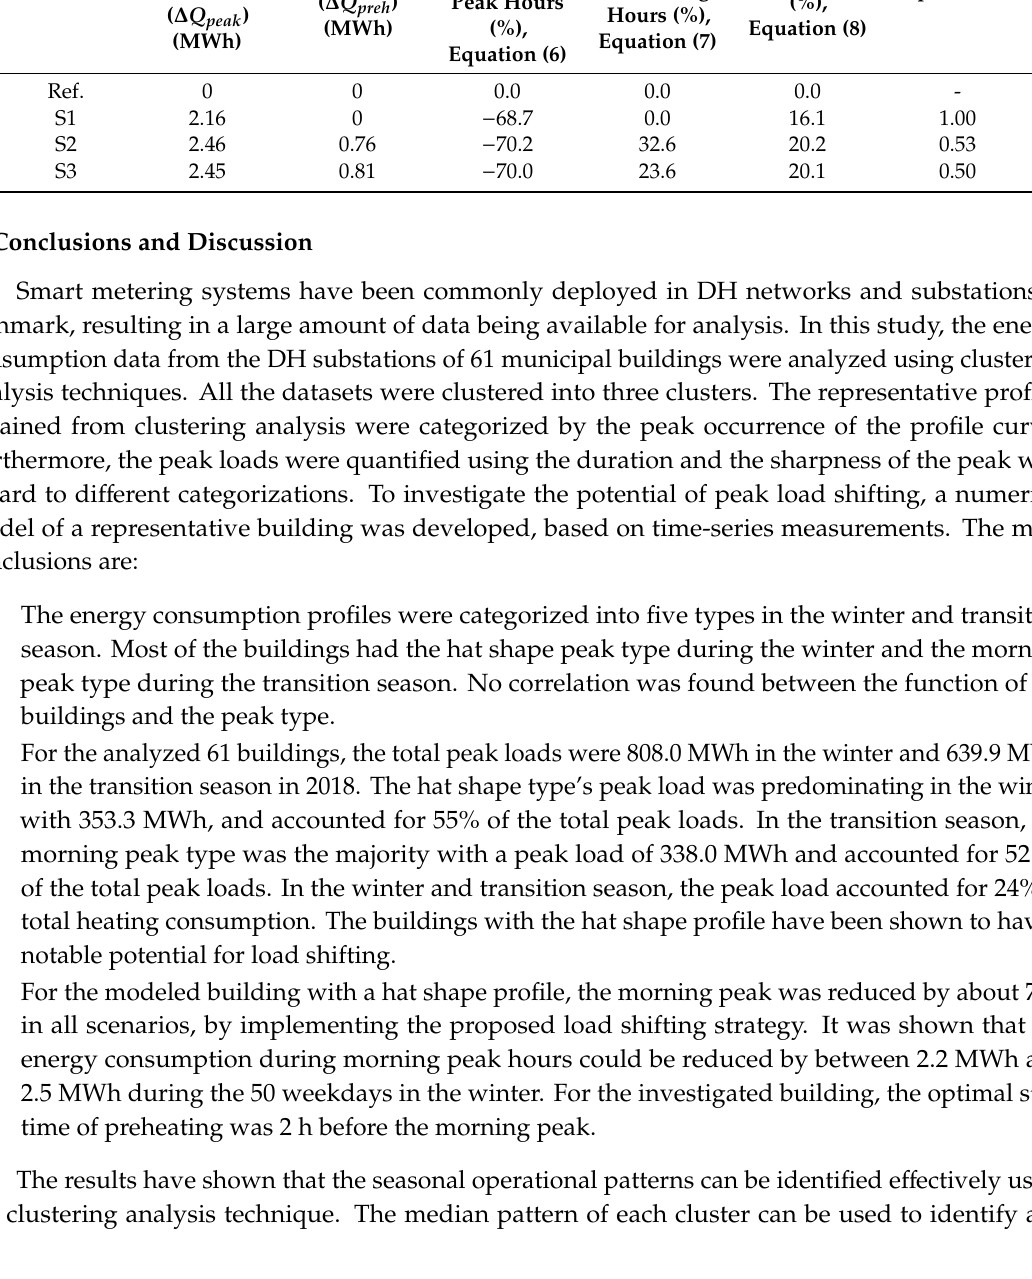
Table 8. Simulation results of load shifting scenarios during the winter of 2018.